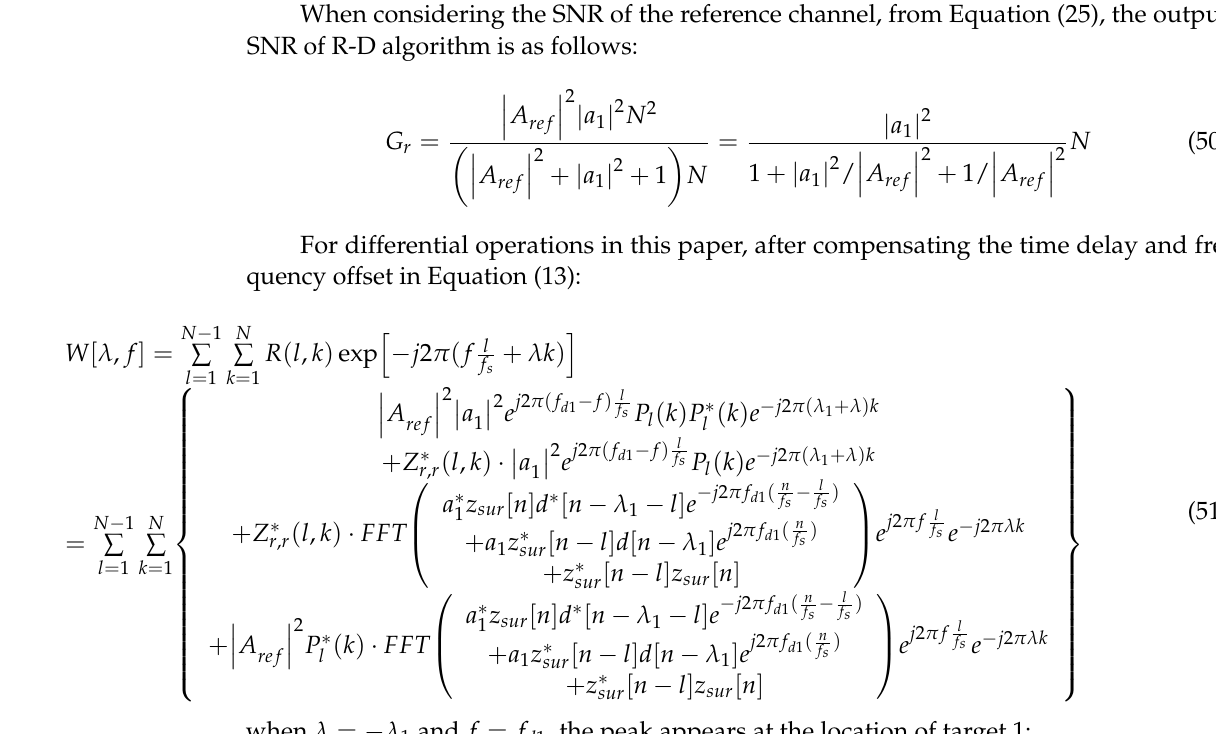
Figure 22. Comparison of the output SNR between the two algorithms: ( a ) comparison under different signal lengths: SNR sur = − 40 dB; ( b ) comparison under different SNR sur : N = 10 4 . 4.2. The Influence of the Reference Channel SNR on the Performance of the